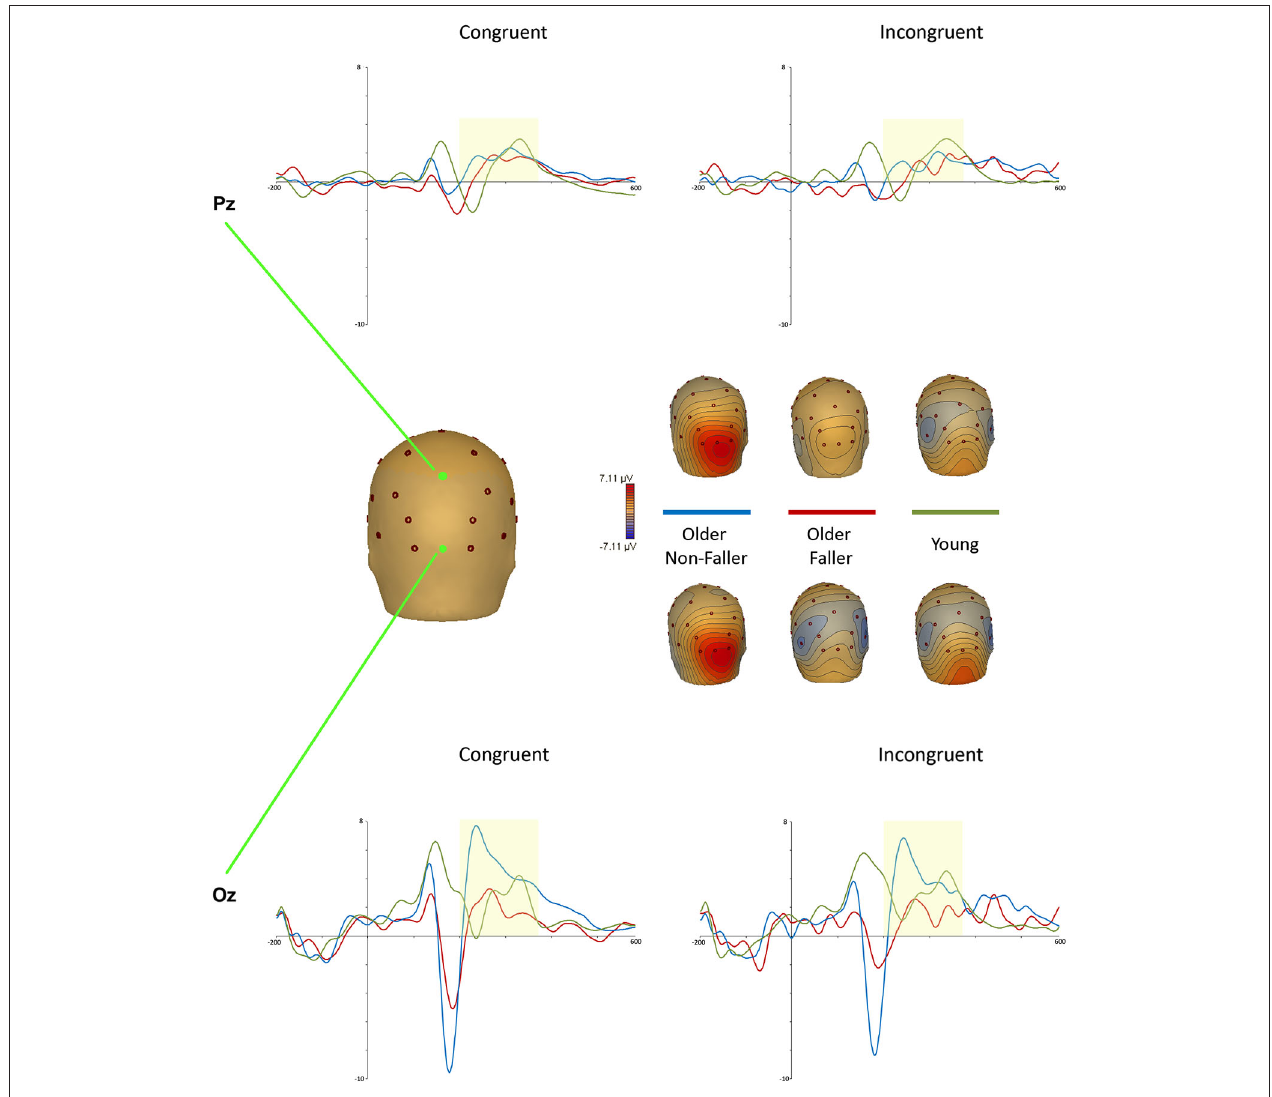
FIGURE 2 | Stroop task P3a event-related potentials (ERPs) recorded at midline and occipital electrodes Pz (top) and Oz (bottom) for young (green), older non-faller (blue) and older faller (red) groups for